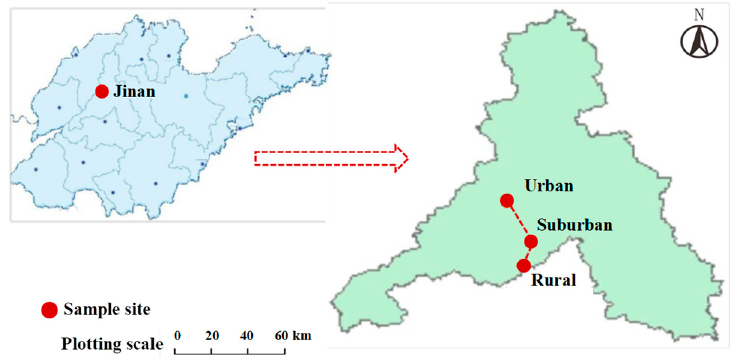
Figure 1. Maps of the sampling site and study area location.